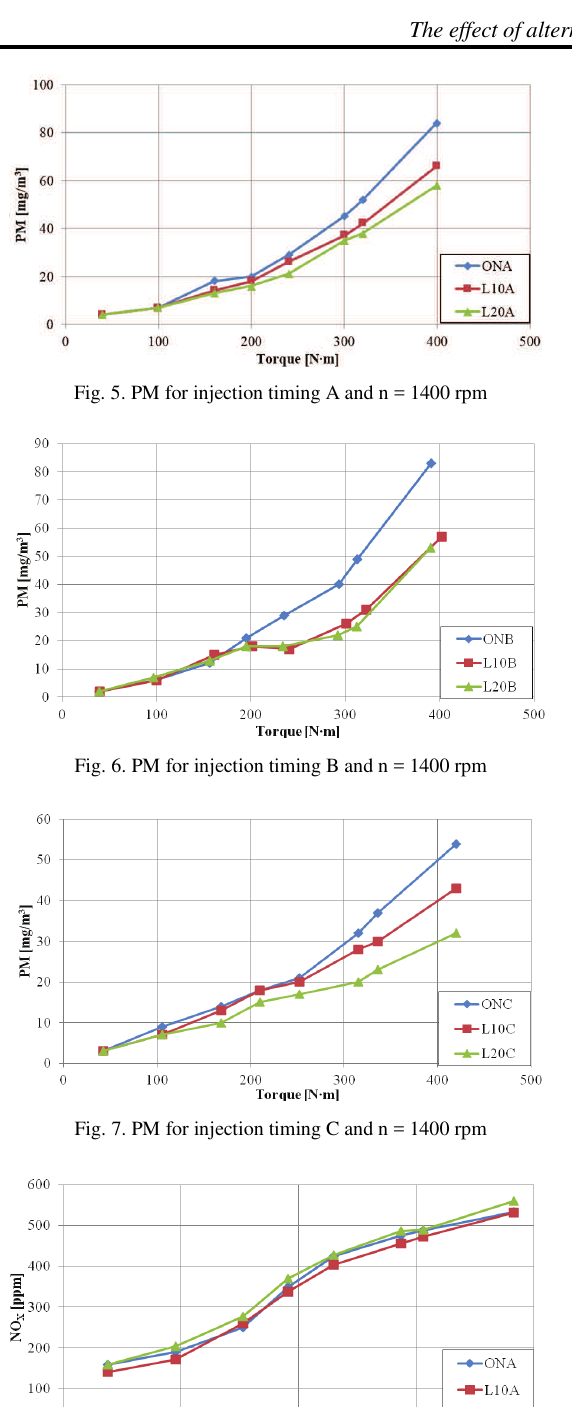
Fig. 12. PM for injection timing B and n = 2000 rpm